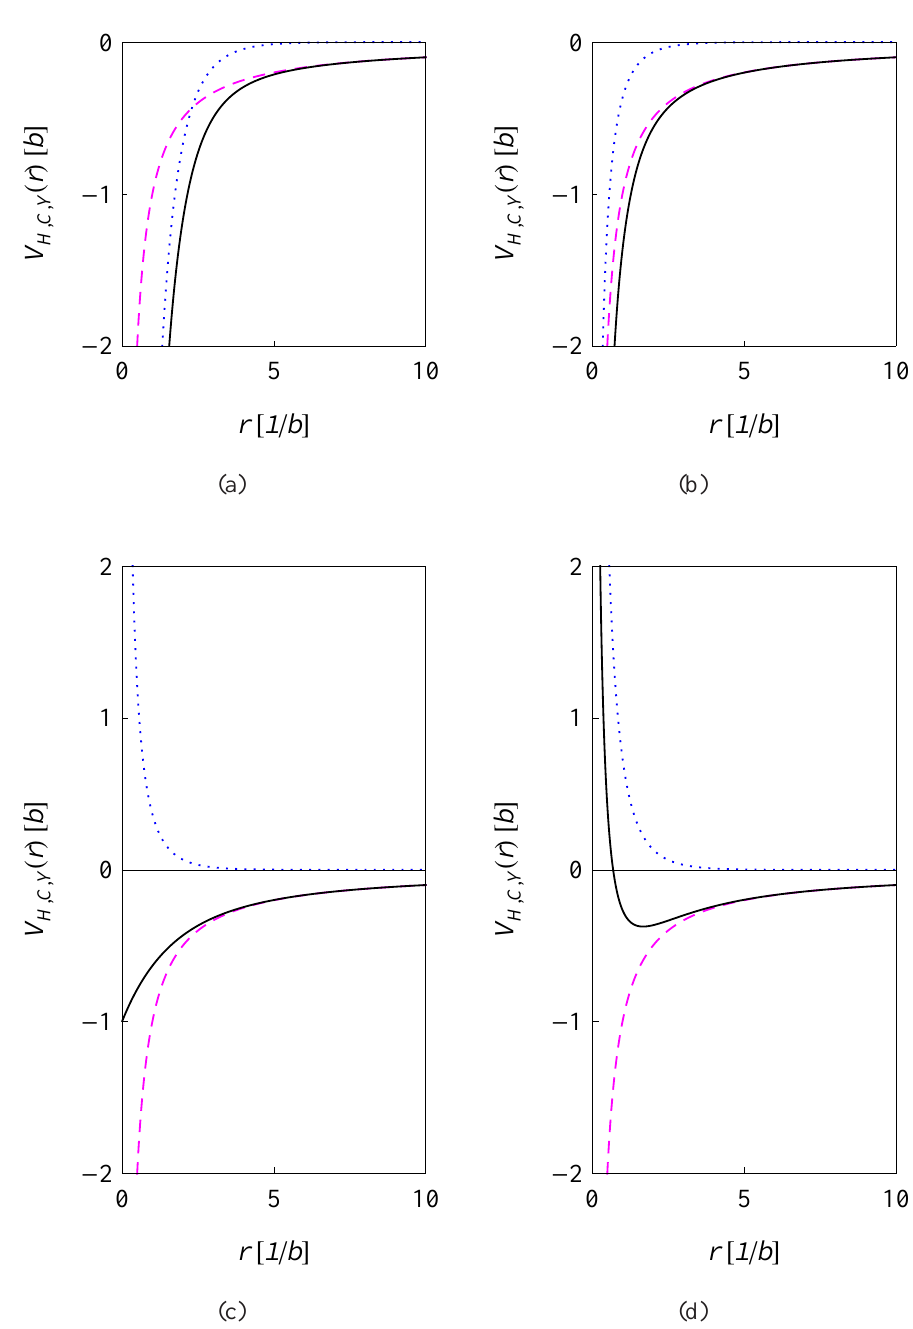
Figure 2. Generic representatives (solid black lines) of four of the only seven distinguishable categories in our systematic classification (Table 1) of generalized Hellmann potentials V H ( r ) defined in Eq. (24) by linear combinations of Coulombic (dashed magenta lines) and Yukawa (dotted blue lines) contributions, choosing κ = 1 and (a) υ = 10, (b) υ = 1, (c) υ = 1, or (d) υ = 2 for the involved coupling − −